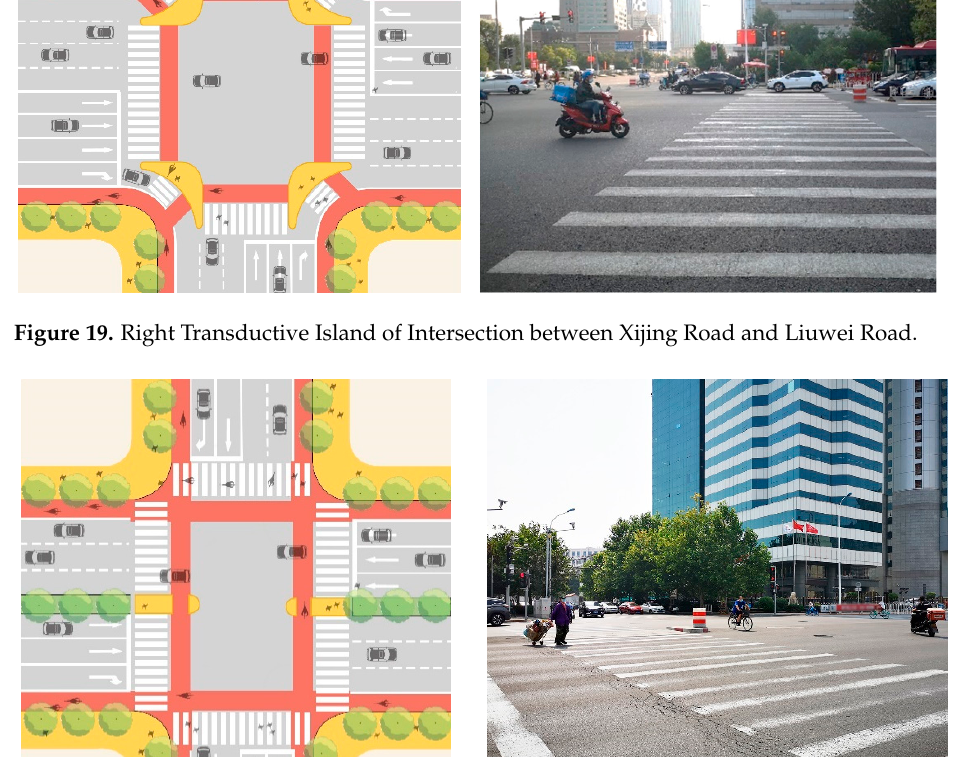
Figure 20. Setting Up a Safety Island at the Intersection of Shiyijing Road and Bawei Road.